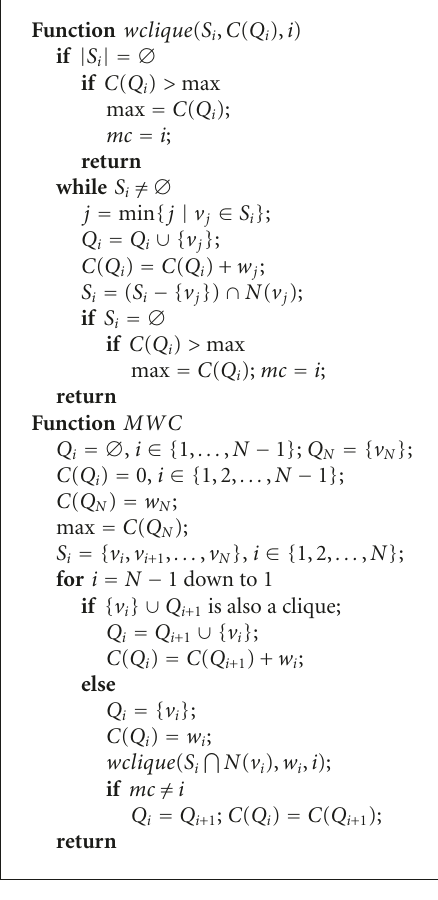
Algorithm 1: Maximum weight clique